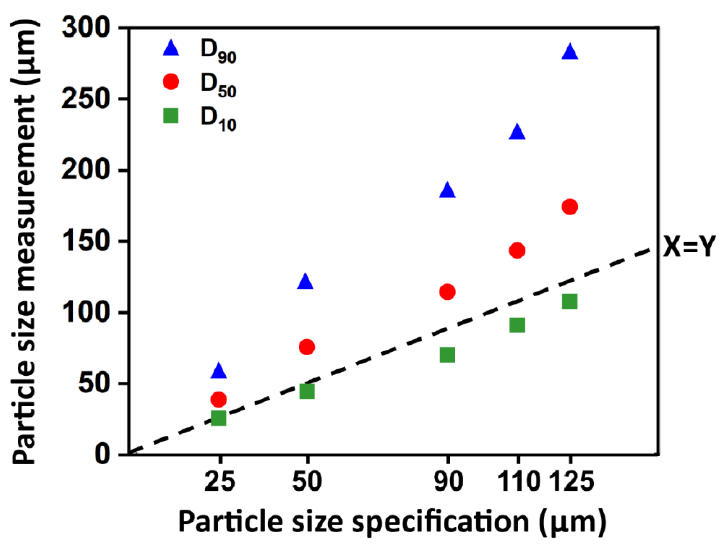
Figure 2. Characteristics of the alumina particle size distributions. There were significant differences among all particle size specifications and the measured particle sizes increased as the particle size specification increased ( p < 0.05).